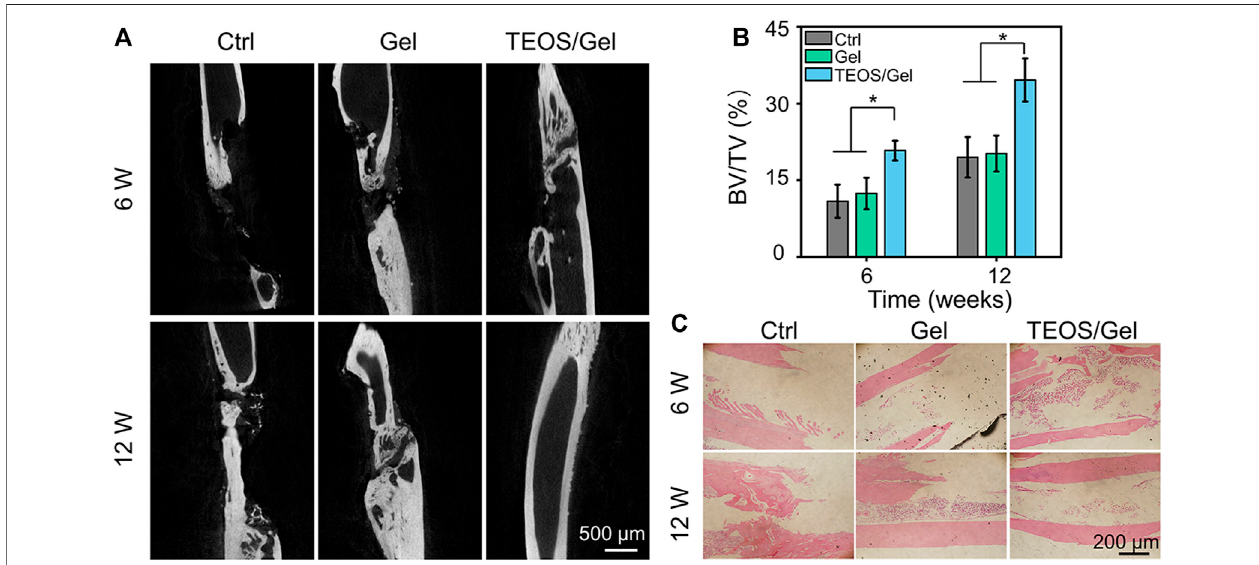
FIGURE 5 | TEOS hydrogel promoted critical-size segmental bone defect repair. (A) Micro-CT images of regenerated bone tissue at the 6th and 12th week after transplantation. (B) Quantitative analysis of BV/TV of the regenerated bone in the defects according to micro-CT. (C) H&E staining for histological observation of radius critical-size defects (* p <